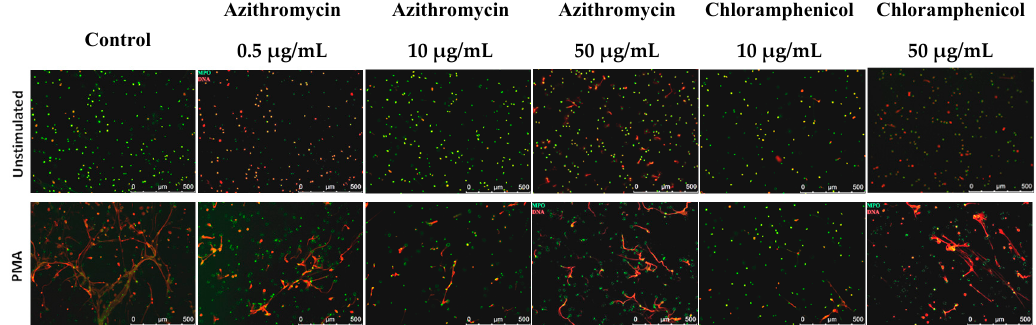
Figure 5. Visualization of the release of NETs performed by fluorescence microscopy after incubation with azithromycin and chloramphenicol, with or without stimulation with 100 nM PMA. The green color represents MPO, red DNA ( n = 6).